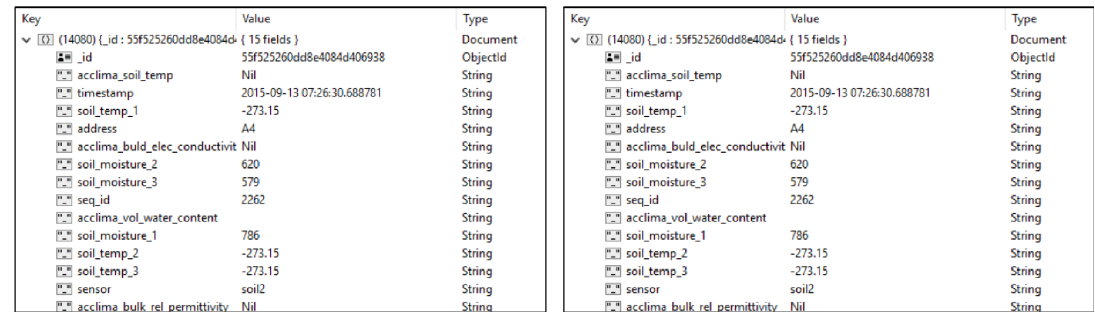
Figure 16. Soil data.